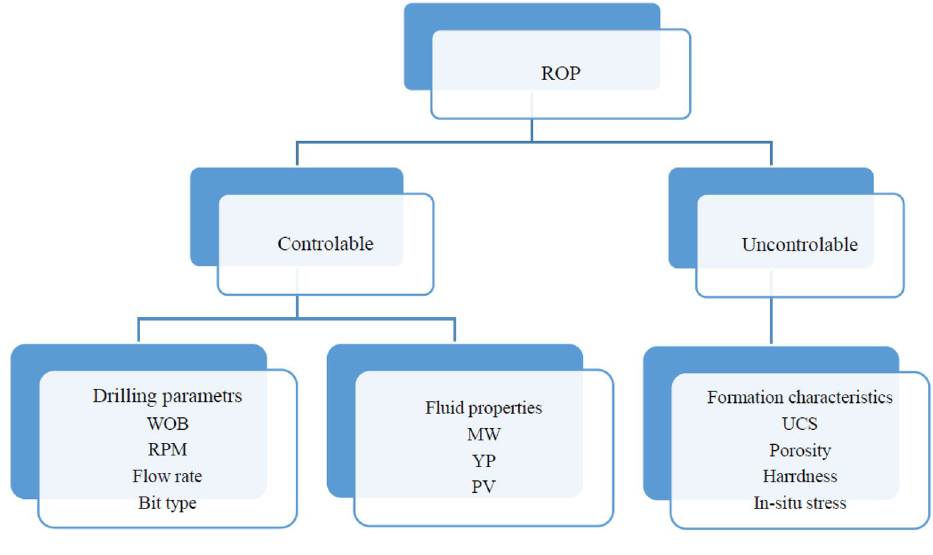
Figure 1. The main factors affecting